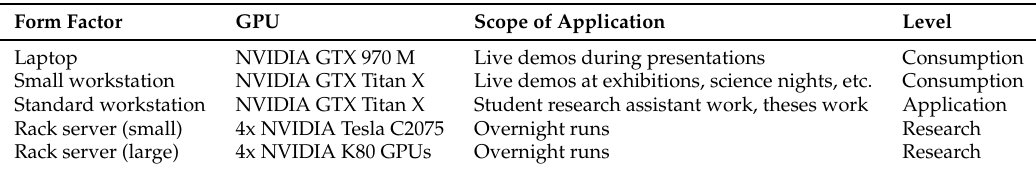
Table 1. Hardware resources that were used for the results presented